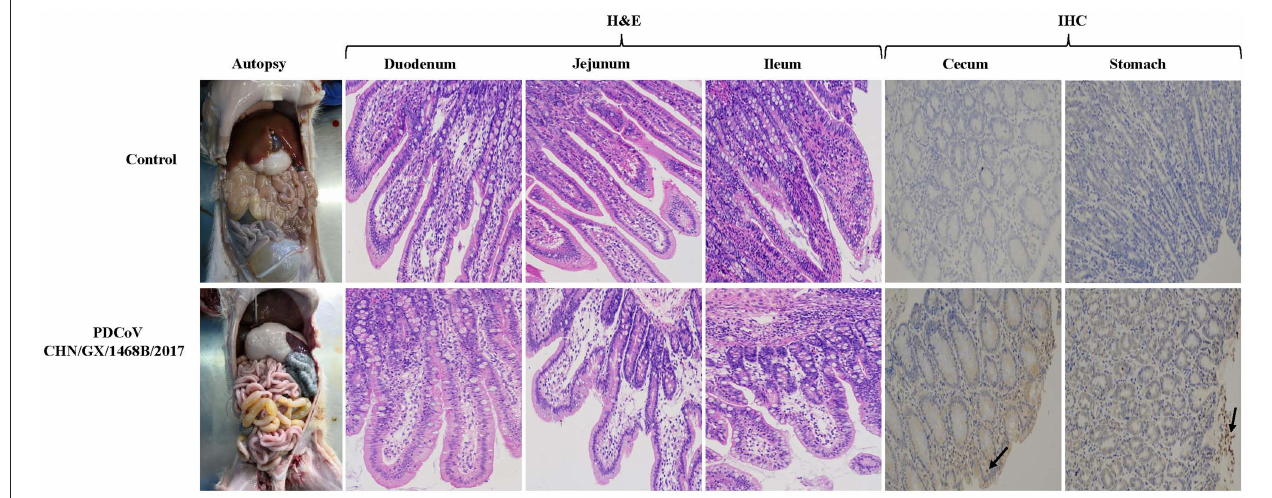
FIGURE 4 | Gross pathological, histopathological and immunohistochemical staining in piglets infected with the PDCoV CHN/GX/1468B/2017 strain. Typical macroscopic intestinal lesions were observed in piglets infected with the PDCoV CHN/GX/1468B/2017 strain by necropsy examination. The small intestine was expanded, filled with yellow water-like liquid and the intestinal wall became thin and transparent. H&E staining showed severe intestinal damage in infected piglets, especially in the small intestine. Obvious visible lesions were observed in the jejunum and ileum, and the villi from these regions were severely atrophied and blunted. In addition, the superficial villi on the epithelial cells were swollen and vacuolated. The duodenal cells were swollen and vacuolated. PDCoV antigen was detected by IHC using PDCoV-N protein specific polyclonal antibody and HRP-labeled goat anti-mouse IgG antibody. PDCoV antigen signals with brown coloring were detected in the cecum and stomach of piglets infected with the CHN/GX/1468B/2017 strain (indicated with black arrows). No antigen was detected in control piglets. (200 × magnification).